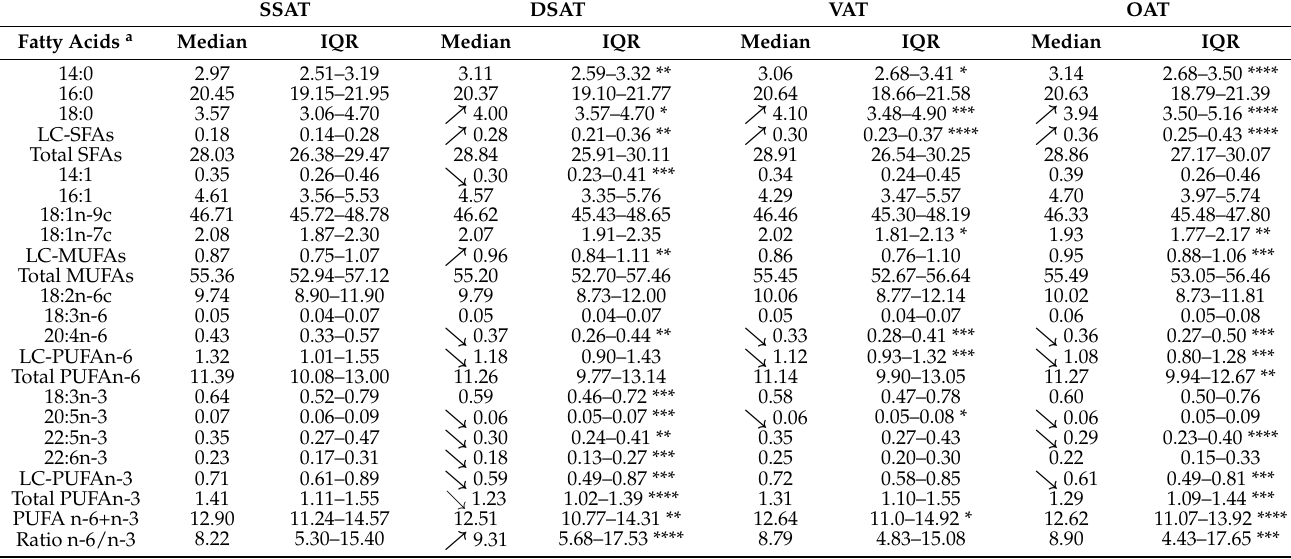
Table 3. Comparison of fatty acid profiles between the four abdominal adipose tissue locations in 34 EOC patients (with two subcutaneous and two visceral